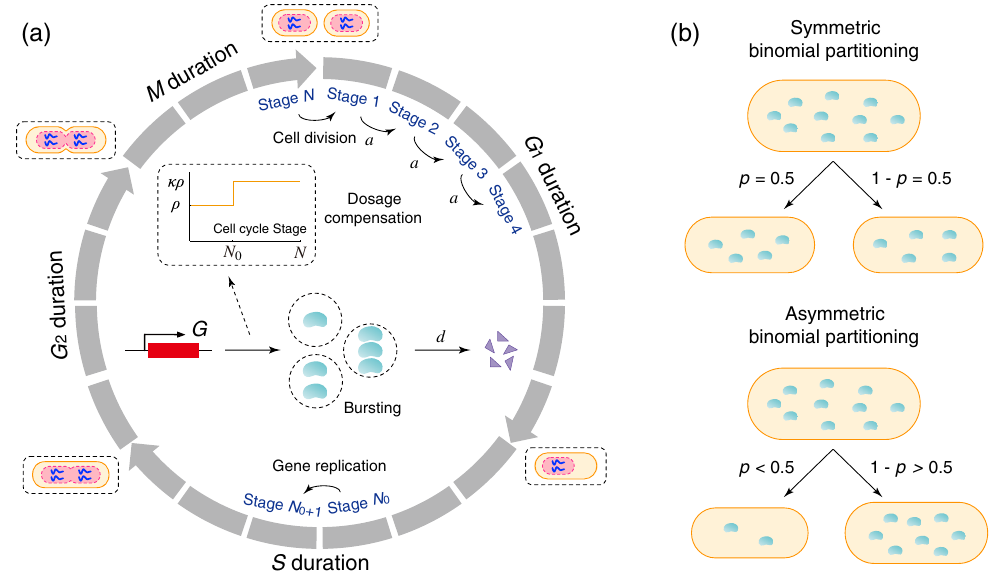
FIG. 1. A detailed gene expression model across the cell cycle. (a) Schematic illustrating the model describing N effective cell cycle stages, gene replication at stage N 0 , bursty production of the gene product, degradation of the gene product, and gene dosage compensation induced by a change in the burst production rate upon replication from ρ to κρ with κ < 2 (see inset graph). (b) At stage N , a mother cell divides into two daughters that are typically different in size (asymmetric division) with the larger daughter inheriting more molecules. Symmetric division is the special case where the daughters are